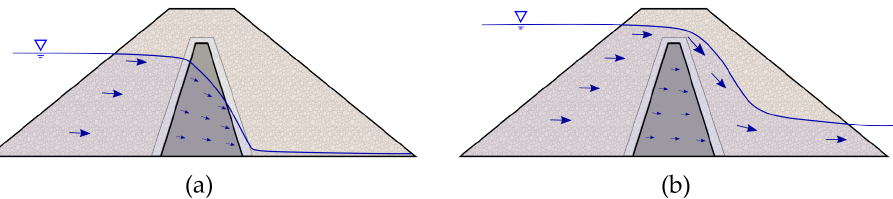
Figure 1. Sketch of throughflow situations for an embankment dam with a central core. ( a ) Normal conditions with seepage through the core. ( b ) Accidental load situation with overtopping of the core leading to large throughflow.